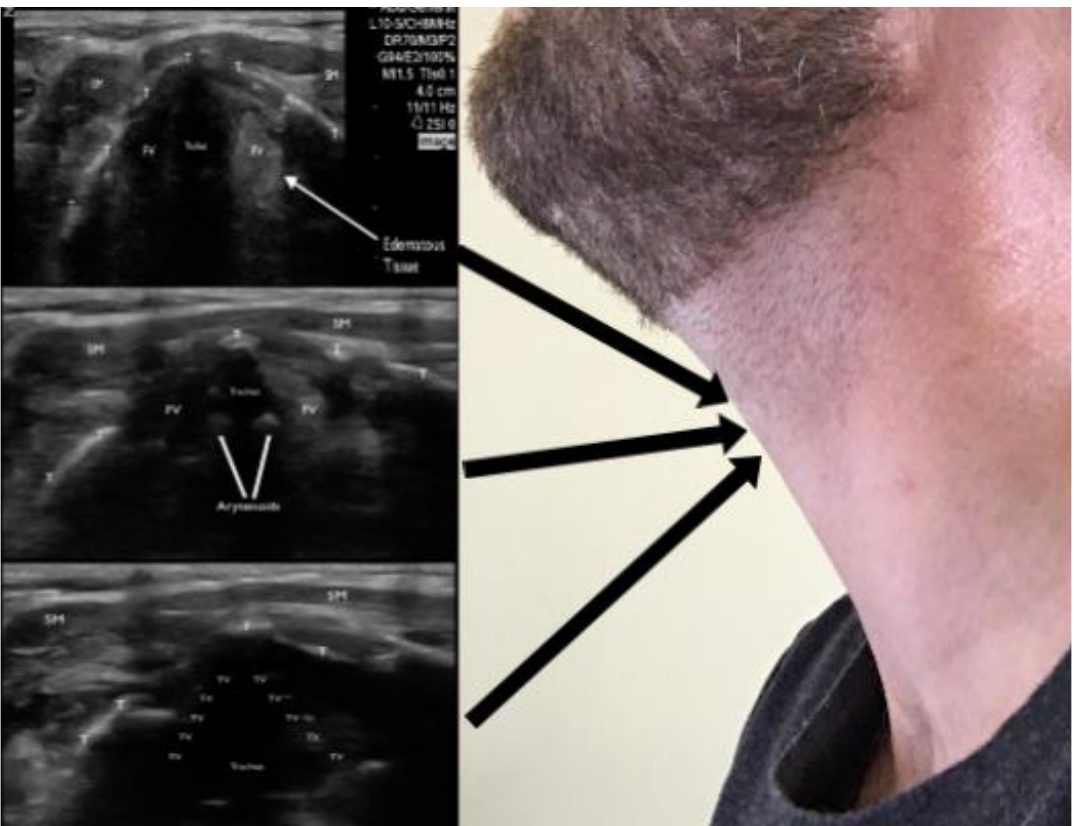
Figure 4. The previous three figures shown at their relative anatomic location. The transducer is held in the transverse plane with the indicator to the patient’s right